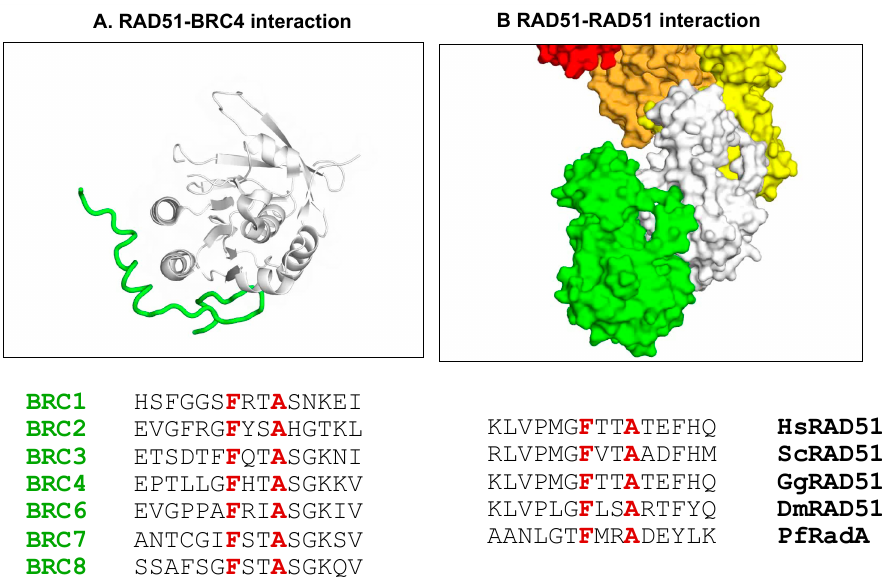
Figure 9. ( A ) The crystal structure of the RAD51–BRCA2 complex, in which during DNA homologous recombination a FxxA motif from BRCA2 folds onto Rad51, with the phenylalanine (F) occupies a deep pocket, before the C-terminal region folds as a helix on to the surface. ( B ) A similar interface involving an FxxA motif is involved in the assembly of the RAD51–RAD51 polymer on DNA